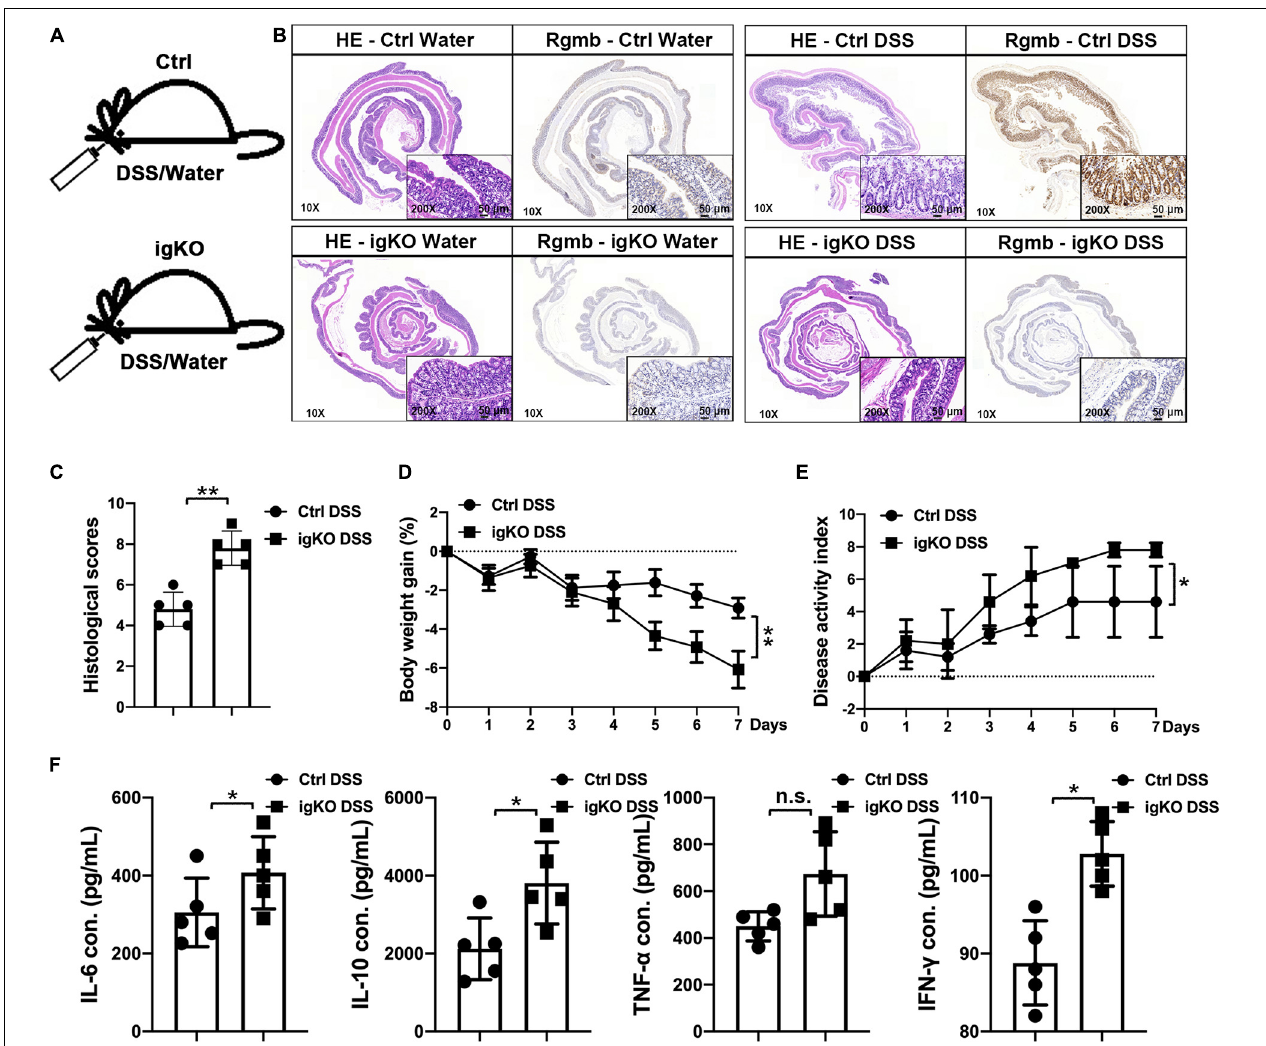
FIGURE 1 | More severe colitis in Rgmb-deficient mice. (A) The schematic diagram showing the protocol for induction of colitis by DSS in Rgmb-deficient (igKO) and control (Ctrl) mice. (B) H&E and IHC staining. H&E staining shows colon tissues of normal or colitis mice with or without DSS treatment. IHC staining indicates that Rgmb was expressed in the colons of control mice, but the signal was lost in Rgmb igKO colons. Brown color represents staining for RGMb protein. Blue represents the nuclei. (C) Histological scores of intestinal tissues of Rgmb-deficient and control mice with colitis. (D) Body weights of colitic Rgmb igKO and control mice. (E) DAI of colitic Rgmb igKO and control mice. (F) Serum concentrations of serum IL-6, IL-10, TNF- α , and INF- γ in colitic Rgmb igKO and control mice. n = 5, * P < 0.05, ** P < 0.01, and n.s., not